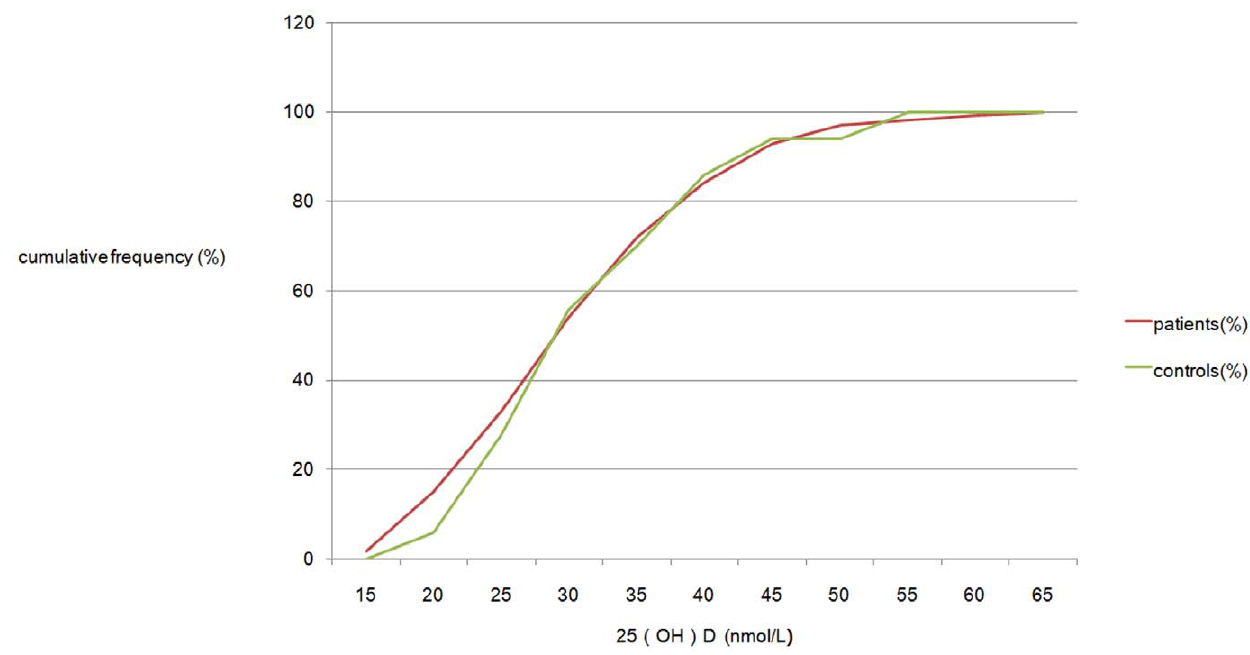
Figure 2. Distribution pattern of 25(OH)D levels in patients and controls from March to May 2011. The horizontal axis represents 25(OH)D levels (nmol/L), the vertical axis represents cumulative frequency of 25(OH)D levels (%). Starting from ‘15 nmol/L’, the largest gap is on ‘20 nmol/L’ point (patients 15.1%, controls 9%, P . 0.05).